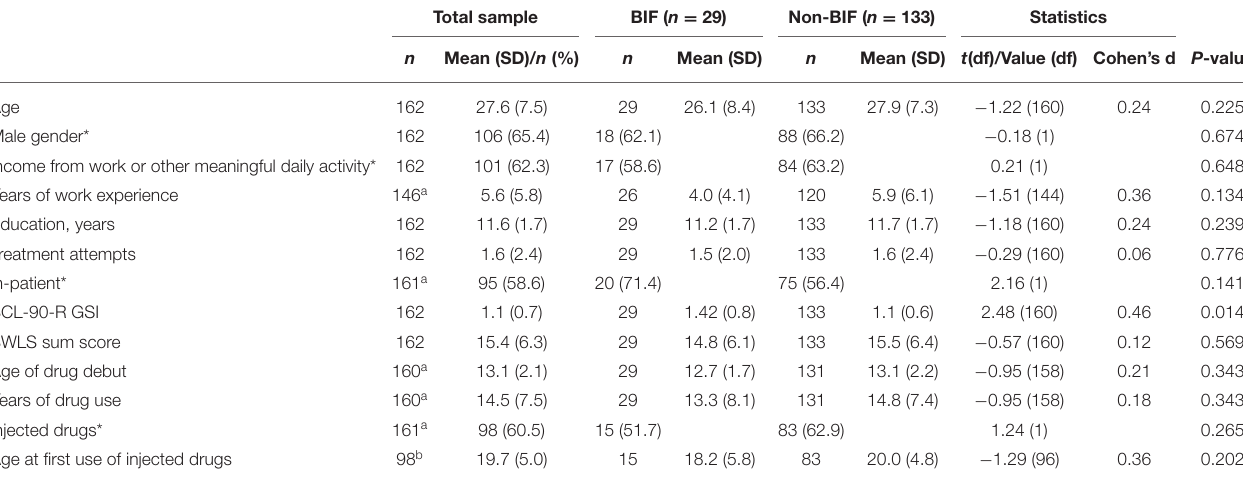
TABLE 1 | Demographic and clinical features of the present sample stratified according to intellectual functioning.